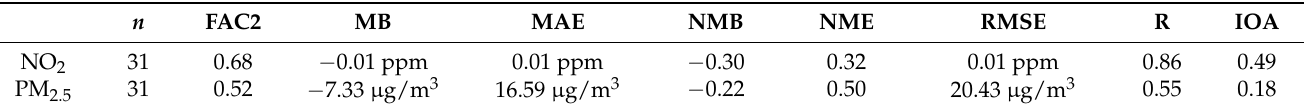
Table 2. Model evaluation